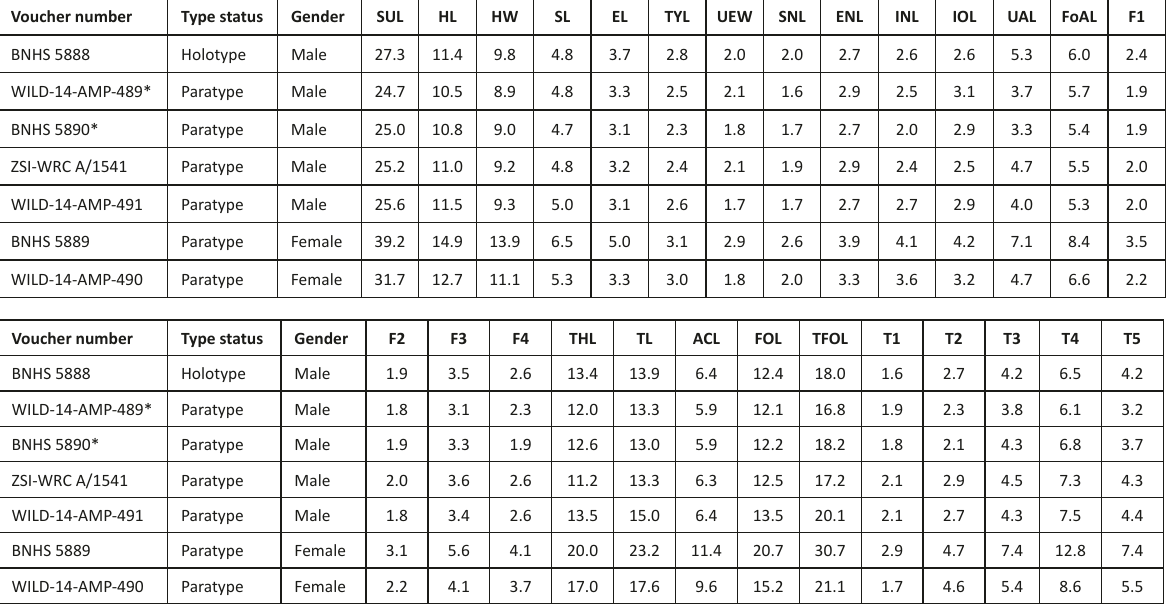
Table 2. Morphometric data (mm) of Indirana chiravasi sp. nov.